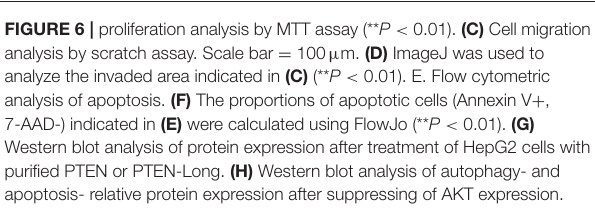
FIGURE 6 | proliferation analysis by MTT assay (** P < 0.01). (C) Cell migration analysis by scratch assay. Scale bar = 100 µ m. (D) ImageJ was used to analyze the invaded area indicated in (C) (** P < 0.01). E. Flow cytometric analysis of apoptosis. (F) The proportions of apoptotic cells (Annexin V + , 7-AAD-) indicated in (E) were calculated using FlowJo (** P < 0.01). (G) Western blot analysis of protein expression after treatment of HepG2 cells